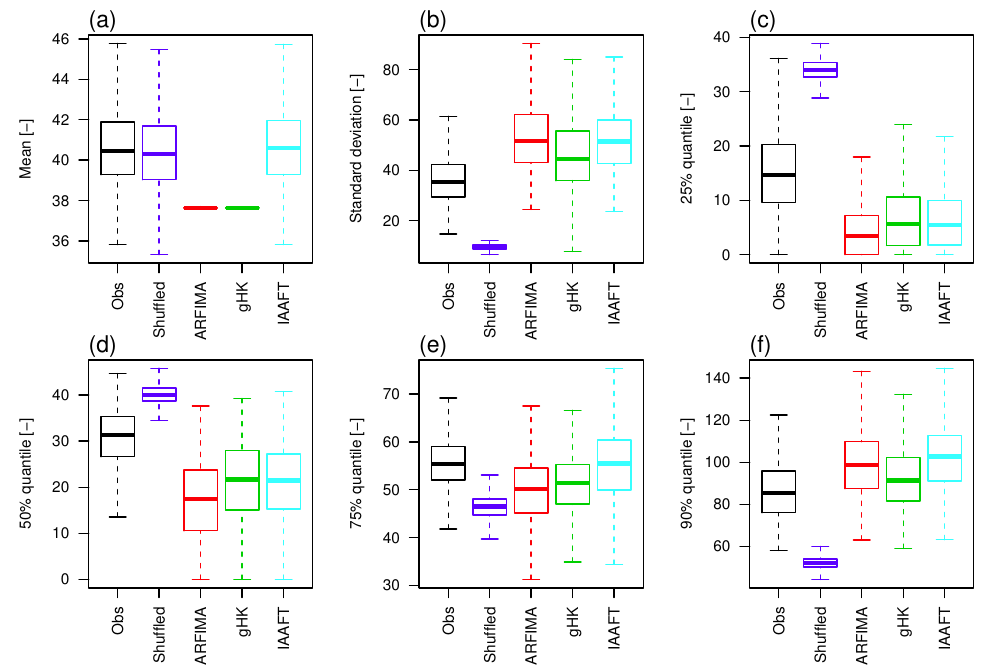
Figure 17. ( a – f ) Summary statistics of S for the 473 time series included in this study, and the 95% quantile threshold.